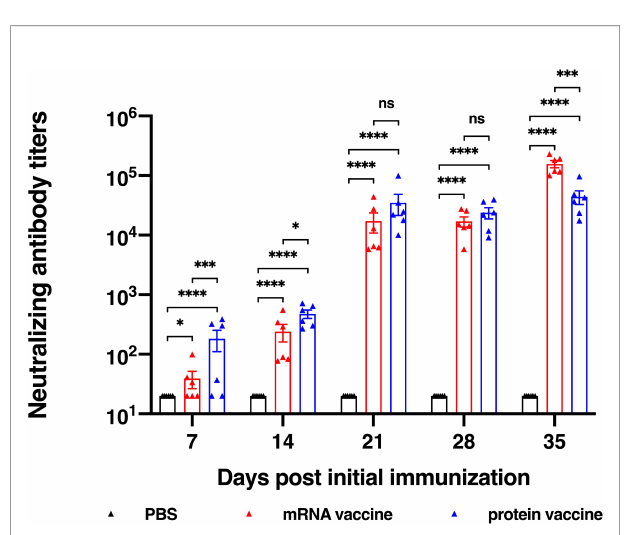
FIGURE 3 | Neutralization ability determined using SARS-CoV-2 pseudovirus. The data are presented as mean± SEM from six mice in each group. PBS was included as the control. Signi fi cance was calculated using unpaired t test (ns, not signi fi cant; *p < 0.05, **p < 0.01, ***p < 0.001, ****p <